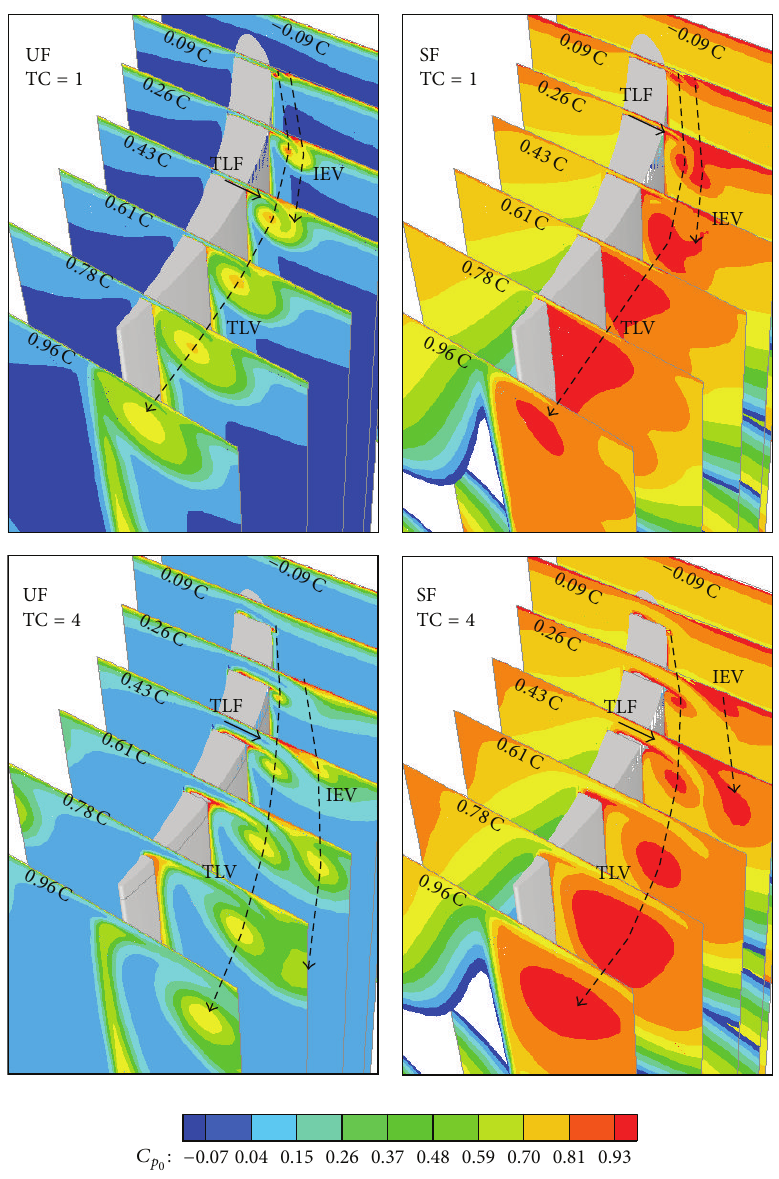
Figure 14: Interaction of TLV (tip leakage vortex), IEV (induced end wall vortex), and TLF (tip leakage flow) with UF and SF at 1% and 4% tip clearance. Total pressure loss contours are